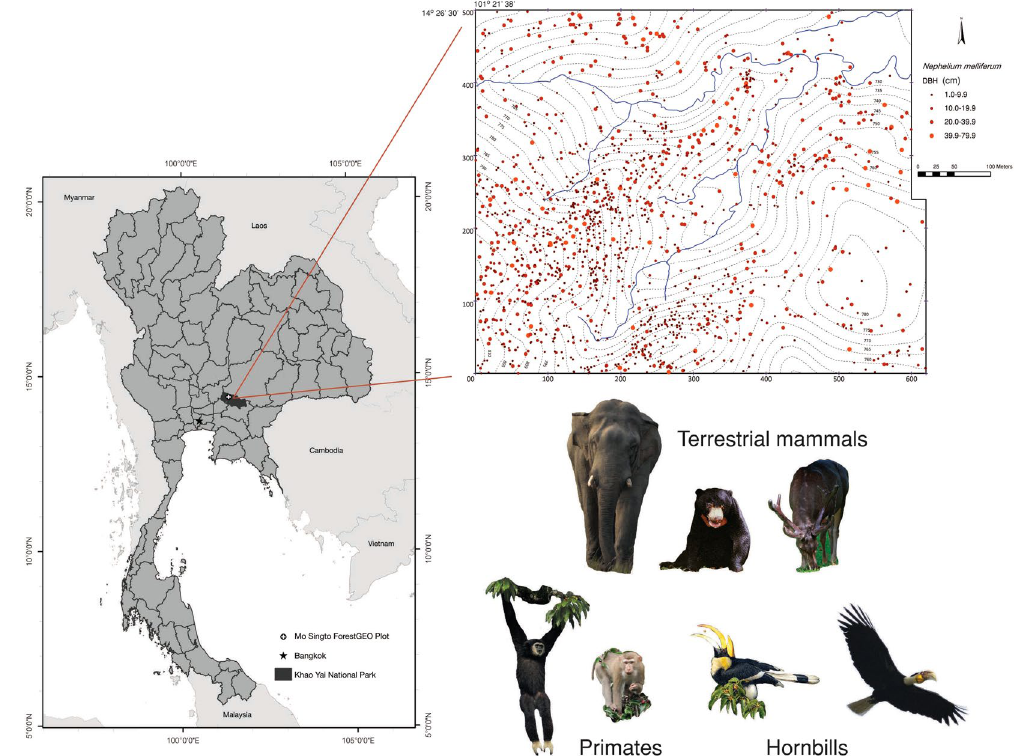
Nephelium melliferum , a hardwood canopy species dispersed mainly by